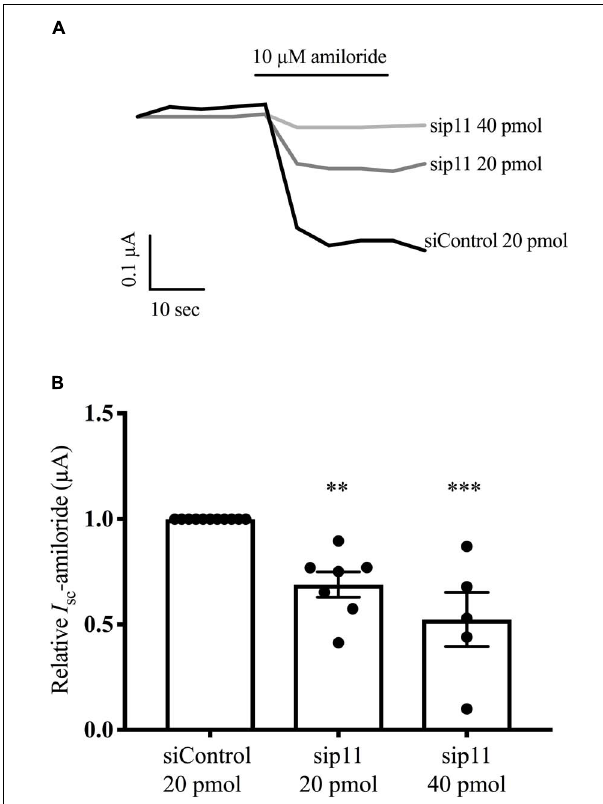
FIGURE 7 | Knockdown of p11 reduces ENaC cell surface levels. FRT epithelia were cotransfected with plasmids encoding α -, β HA -, and γ ENaC (1 µ g each) together with either control siRNA or increasing amounts of p11 siRNA (20 and 40 pmol). Cell surface proteins were labeled with Sulfo-NHS-LC-biotin and captured on Neutravidin beads after cell lysis. β HA ENaC was detected in both the cell surface and whole cell lysate fractions. (A) Representative immunoblot of surface β HA ENaC. (B) Pooled results show a significant decrease in the cell surface population of β HA ENaC with 40 pmol sip11, n = 3, ∗∗ p < 0.01 by one-way ANOVA followed by Bonferroni’s